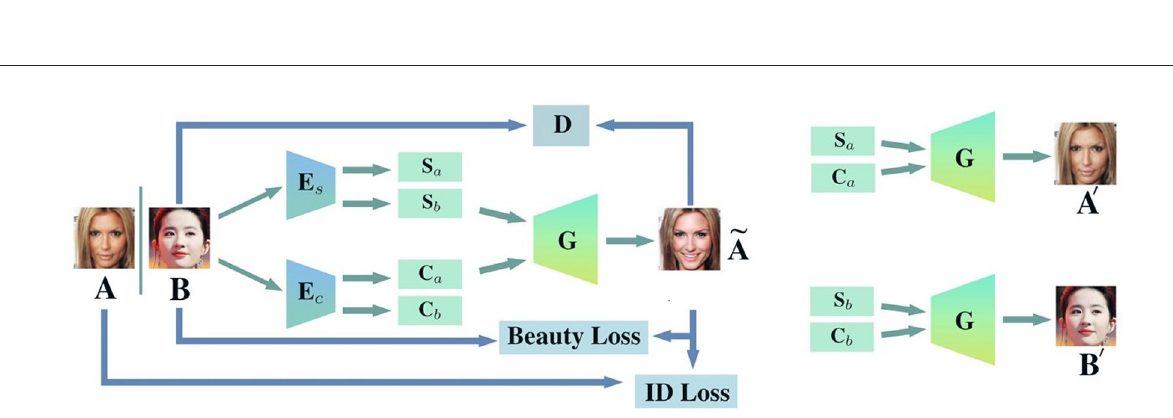
FIGURE2 Overview of the proposed network architecture (training phase). Left: given a source image A and a target image B, our objective is to transfer the style of target image B to A in a continuous (fine-granularity control) manner. Right: ( S a / b , C a / b ) denote the style-content encoder for images A / B respectively ( A ′ , B ′ denote the reconstructed images of A , B ).